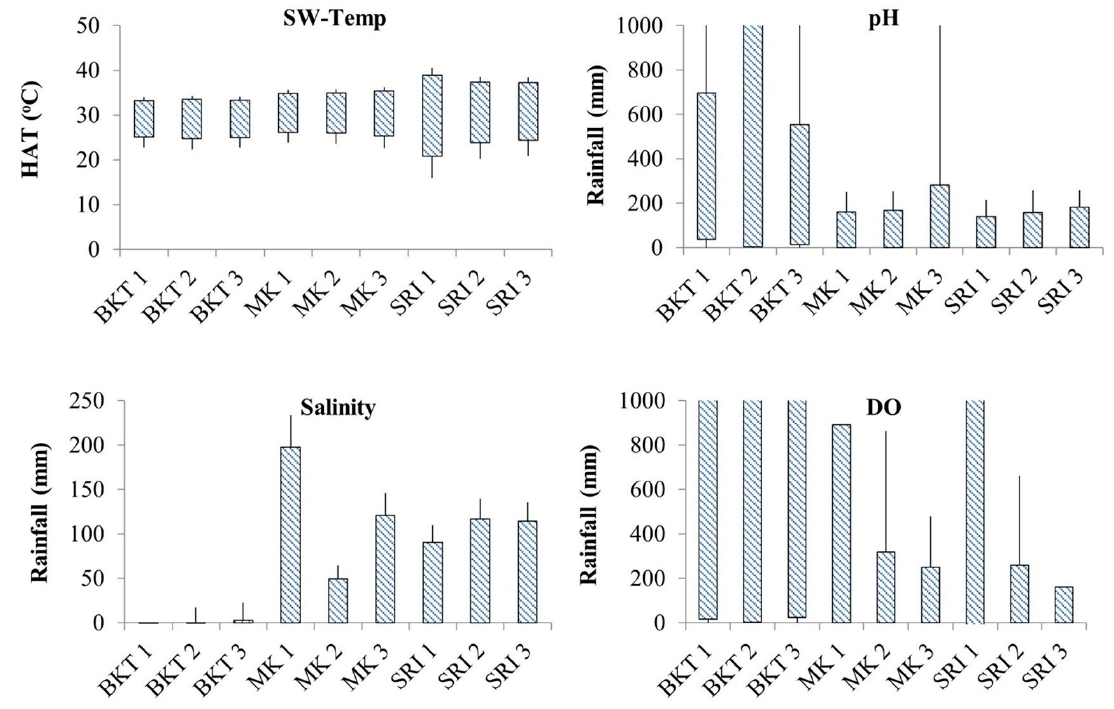
Fig. 8. – Bar charts representing (from top to bottom), the maximum lethal level, upper survival level, lower survival level and minimum lethal level of atmospheric parameters (average of the highest temperature (HAT) and rainfall) that were estimated from seawater temperature (SW- Temp), pH, salinity, and dissolved oxygen (DO) in the pond area of Bang Khun Tien (BKT), the estuary area of the Maeklong river mouth (MK) and the coastal area of Sriracha